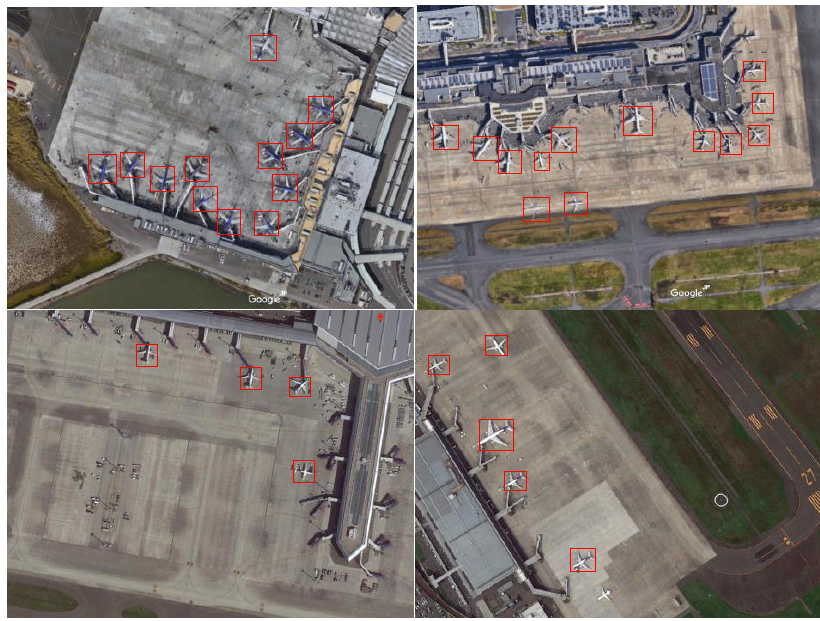
Figure 6. Results of the proposed airplane detection method.